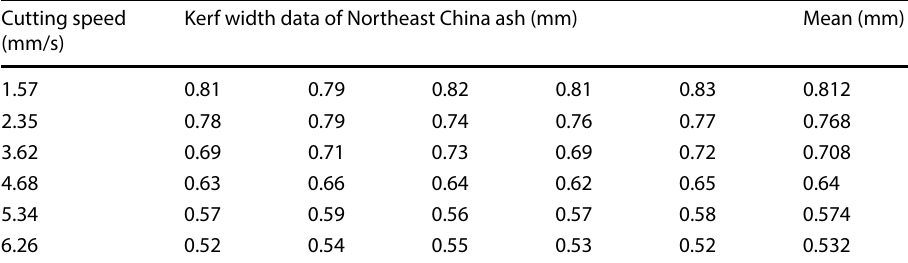
Table 14 Kerf width data of Northeast China ash ( Fraxinus mandshurica ) under M